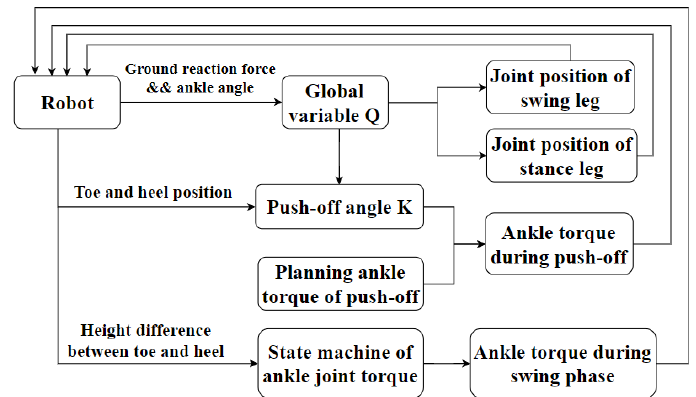
Figure 6. Overall controller framework of the planar biped robot.